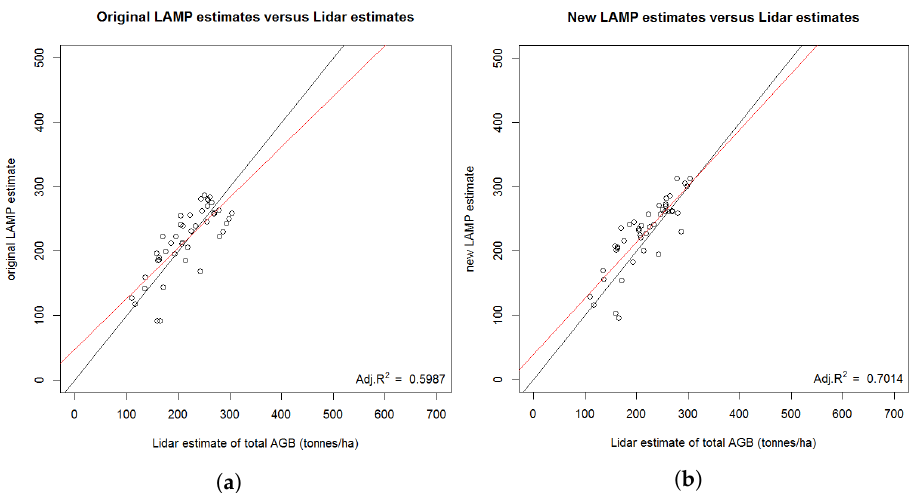
Figure A4. AGB predictions with LAMP3 at 100-hectare scale compared to Lidar estimates. ( a ) OLSLAMP; ( b ) LAMP3. Regression trend line of the linear model in red, optimal trend line in